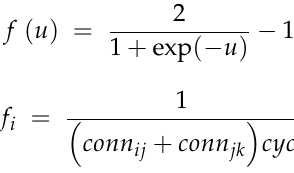
Table 3. Summary of studies reviewed for aeroelastic response. Study